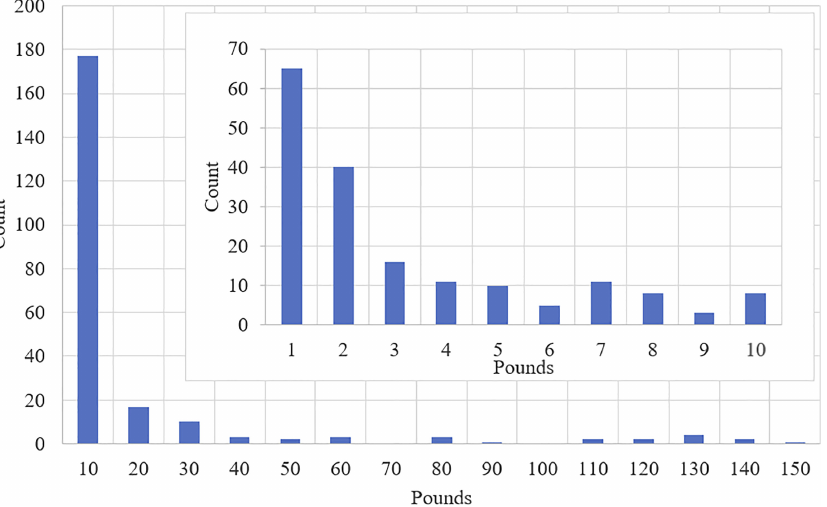
Figure 3. Mission critical